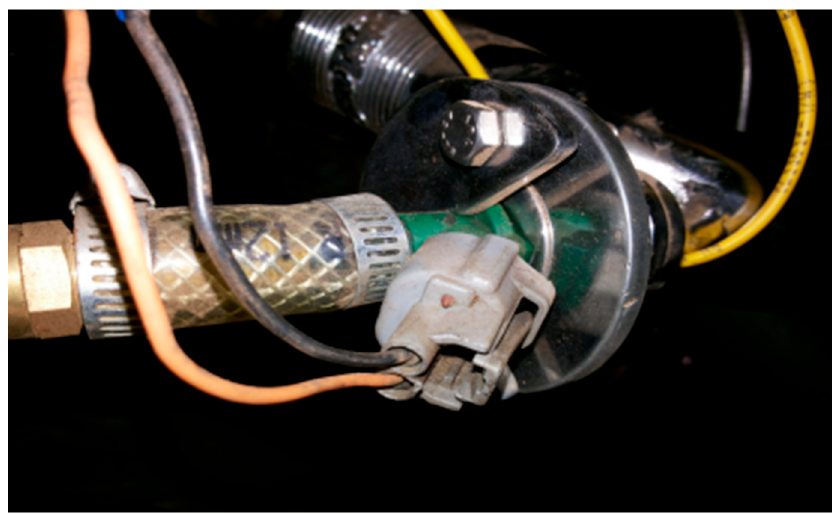
Figure 1. Installation of an ethanol injector in an intake manifold.